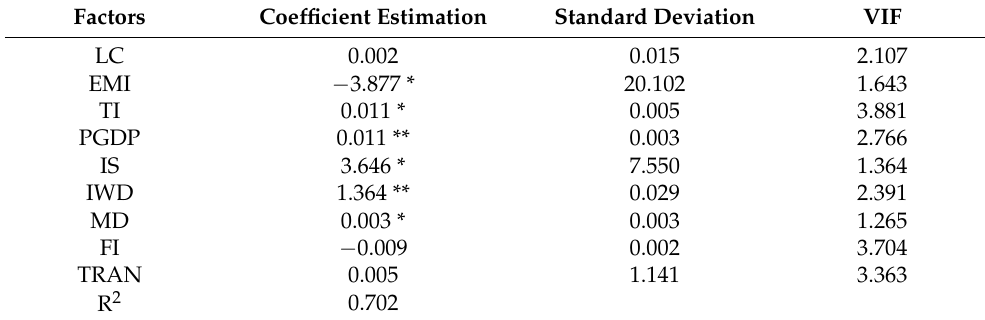
Table 4. Coefficient estimation of OLS model. Factors